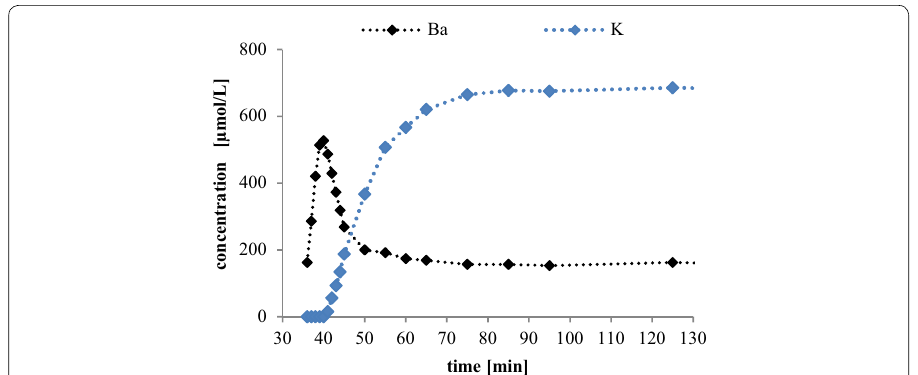
m. : 2 cm 3 /min, initial K and Ba concentrations: 1907 and